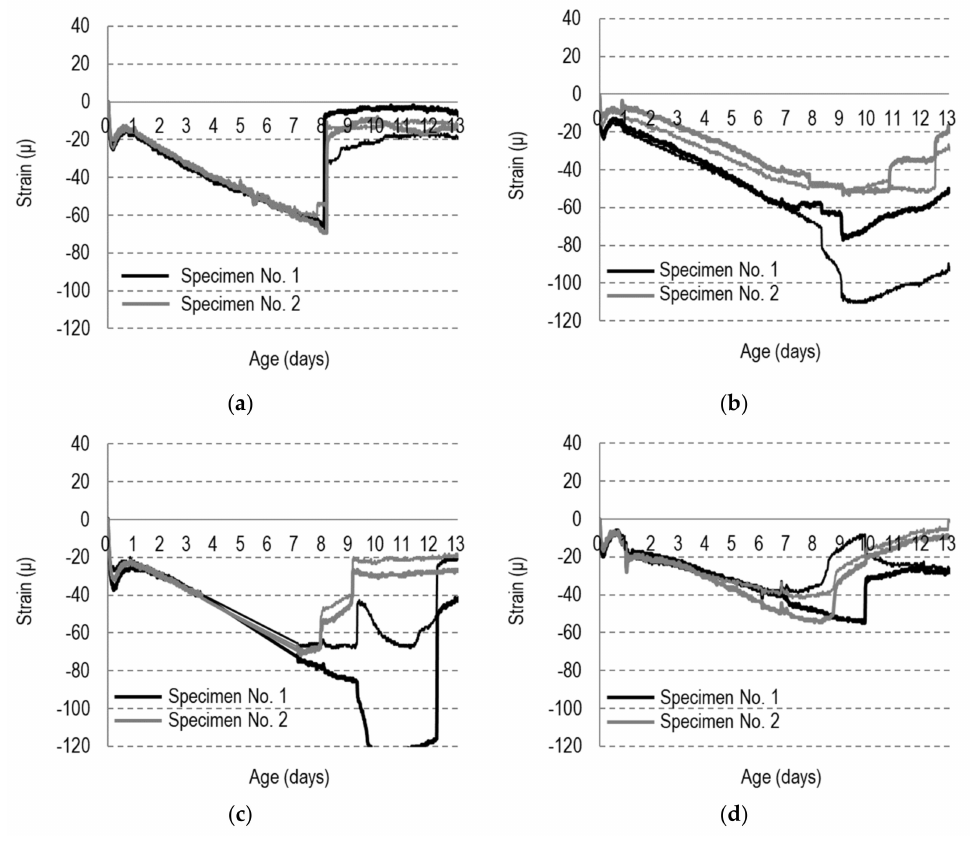
Figure 6. Strain history of inner ring (W170 mixtures): ( a ) D10, ( b ) D20, ( c ) D40, and ( d ) D60.